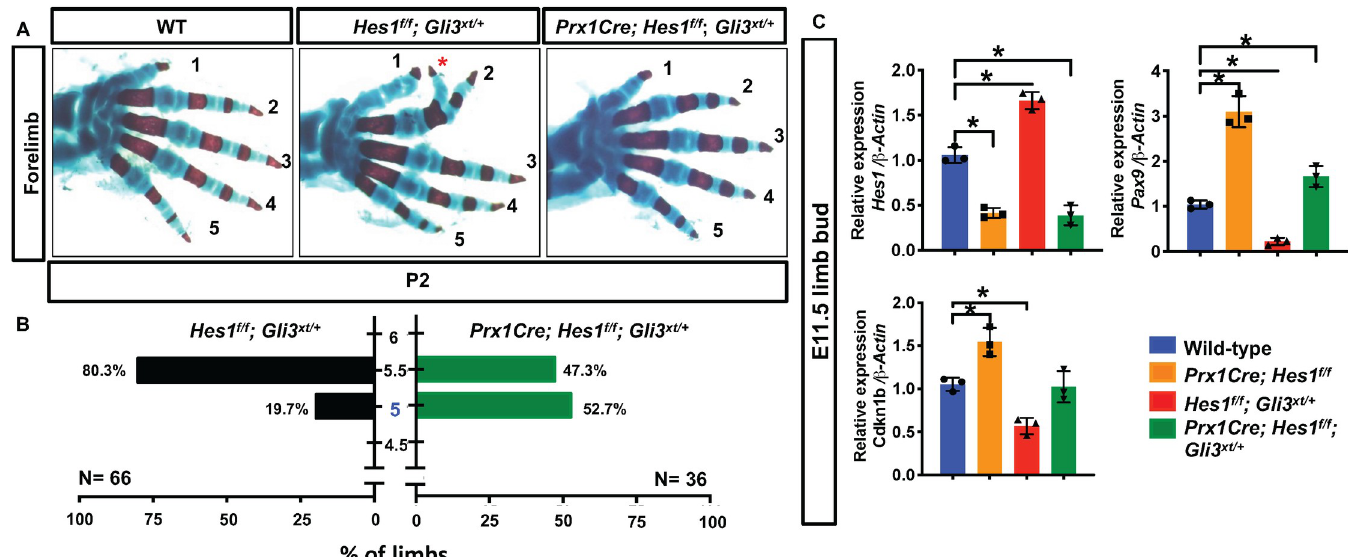
Fig 8. HES1 is a critical effector of SHH-induced PPD. (A) Alcian Blue/Alizarin Red staining of WT, Hes1 f/f ; Gli3 xt/+ (GLI3 HET), and Prx1Cre; Hes1 f/f ; Gli3 xt/+ (HES1 LOF/GLI3 HET) double mutant forelimbs. Red asterisk indicates syndactylous digit. (B) Quantification of digit numbers for WT, GLI3 HET (N = 66) and HES1 LOF/ GLI3 HET (N = 36) double mutant forelimbs ( χ 2 test) (p-value < 0.0001). Y axis represents the number of digits whereas the x-axis represents the percent of the forelimbs. Intervals of 0.5 represent syndactylous digits. (C) qPCR for Hes1 , Pax9 , and Cdkn1b on RNA from E11.5 WT, Prx1Cre; Hes1 f/f (HES1 LOF), Hes1 f/f ; Gli3 xt/+ (GLI3 HET), and Prx1Cre; Hes1 f/f ; Gli3 xt/+ (HES1 LOF/GLI3 HET) double mutant limb buds (N = 3). Each data point represents separate animals. Asterisks indicate significance with a p-value < 0.05 (One-way ANOVA).